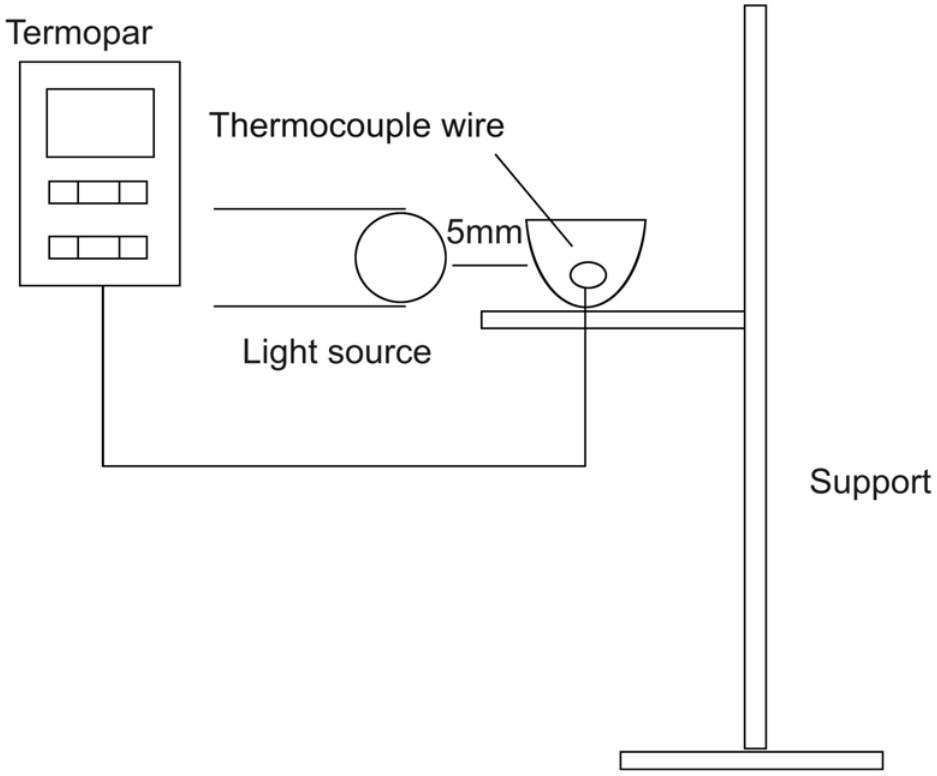
FIGURE 1- Schematic drawing of the experimental set up showing the temperature